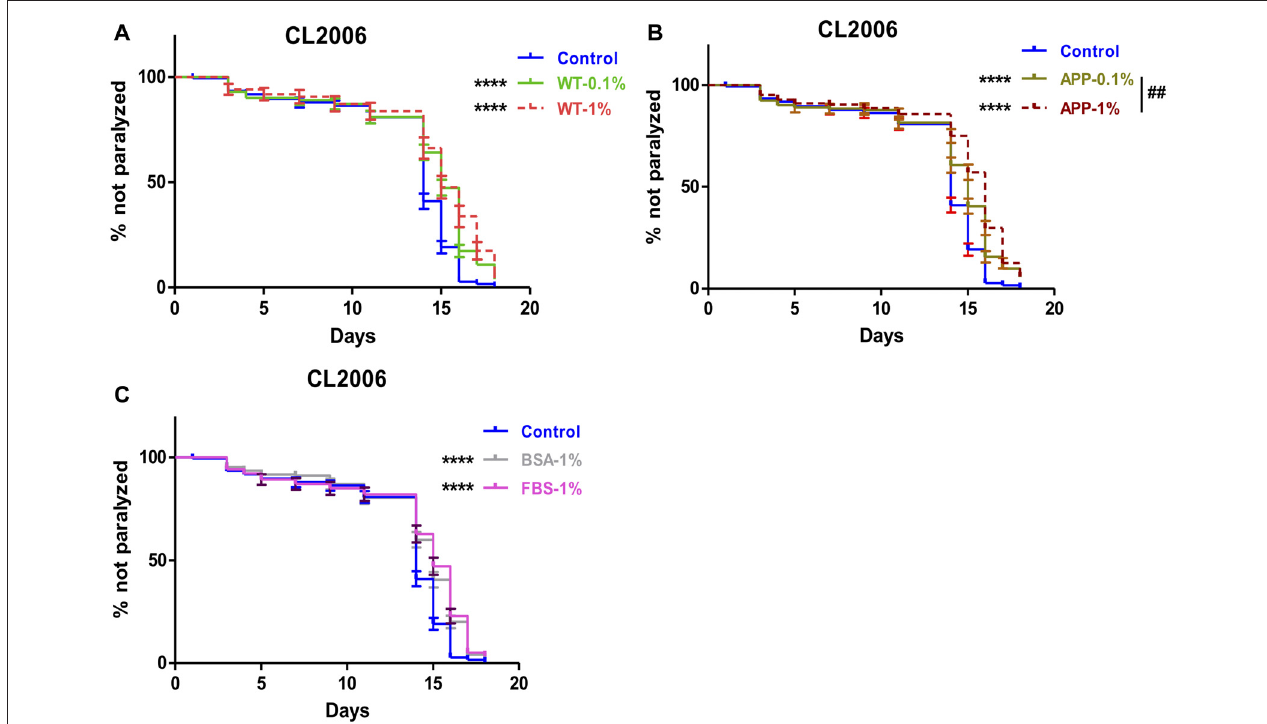
FIGURE 2 | A β -induced paralysis was delayed in AD transgenic nematode CL2006 treated with brain extracts. (A) The effect of feeding brain extracts from WT mice at 0.1% and 1% concentration. (B) The effect of feeding brain extracts from AD transgenic mice at 0.1% and 1% concentration. (C) The effects of feeding 1% BSA and 1% FBS. Data were analyzed using a paired log rank survival test. The level of significance was shown in brackets ( ∗∗∗∗ P < 0.0001, ## P < 0.01).